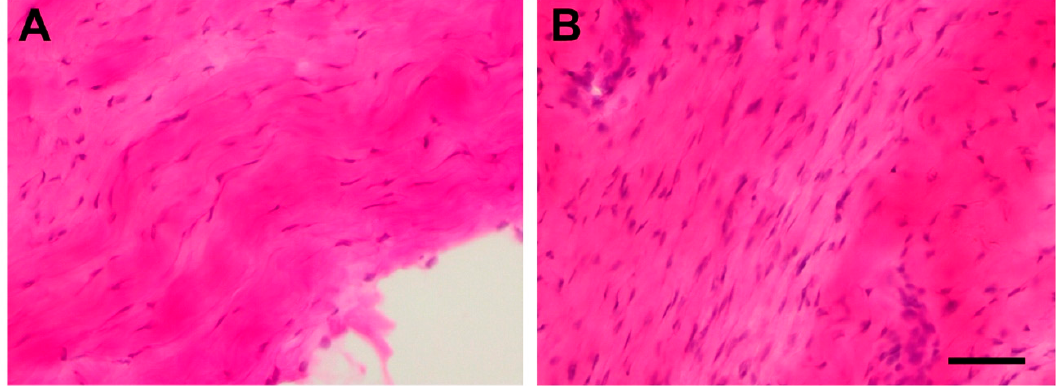
Figure 3. Stained longitudinal images with hematoxylin–eosin of a normal Achilles tendon ( A ) and of an injured Achilles tendon of rats euthanized after one week after injection of collagenase ( B ). The scale bar is at 50 μ m.